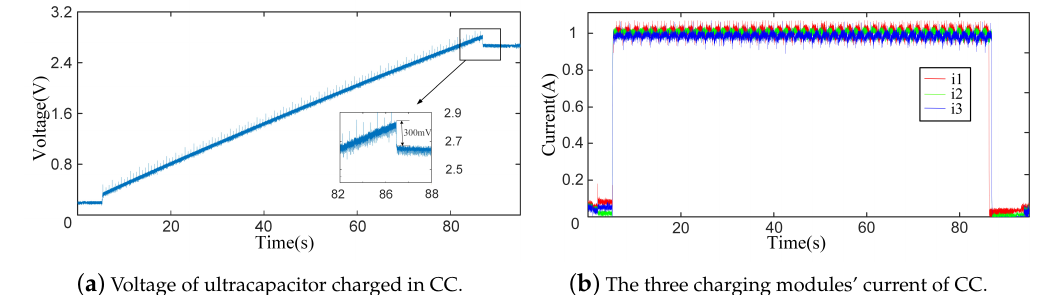
Figure 8. The CC charging profiles.